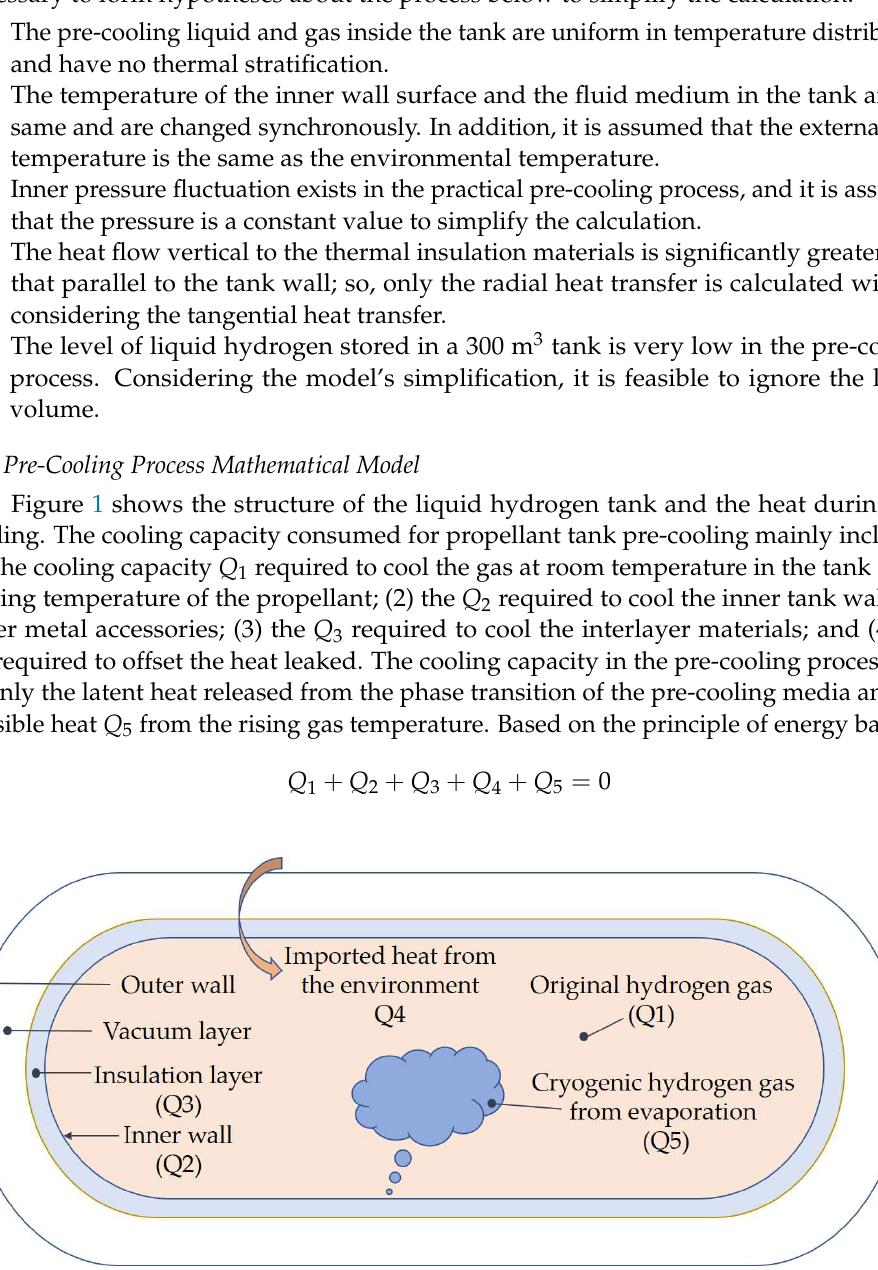
Figure 1. Structure of liquid hydrogen tank and heat during pre-cooling.